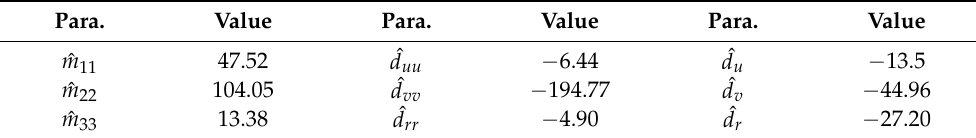
Table 1. Model parameters of WL-II. Para. Value Para. Value Para. Value